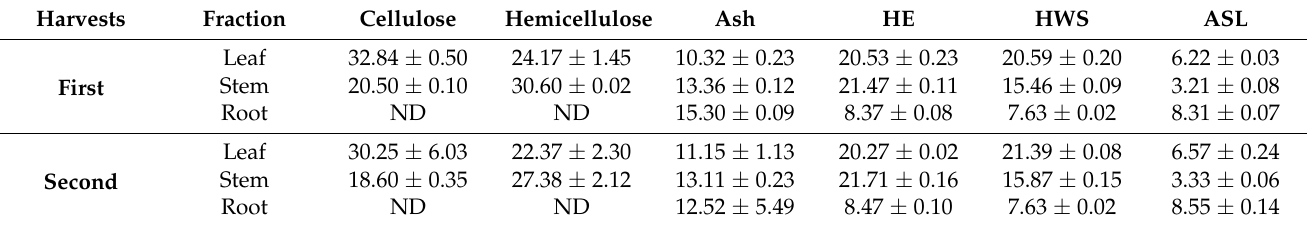
Table 3. Characterization of water hyacinth composition (% dry weight) from Lake